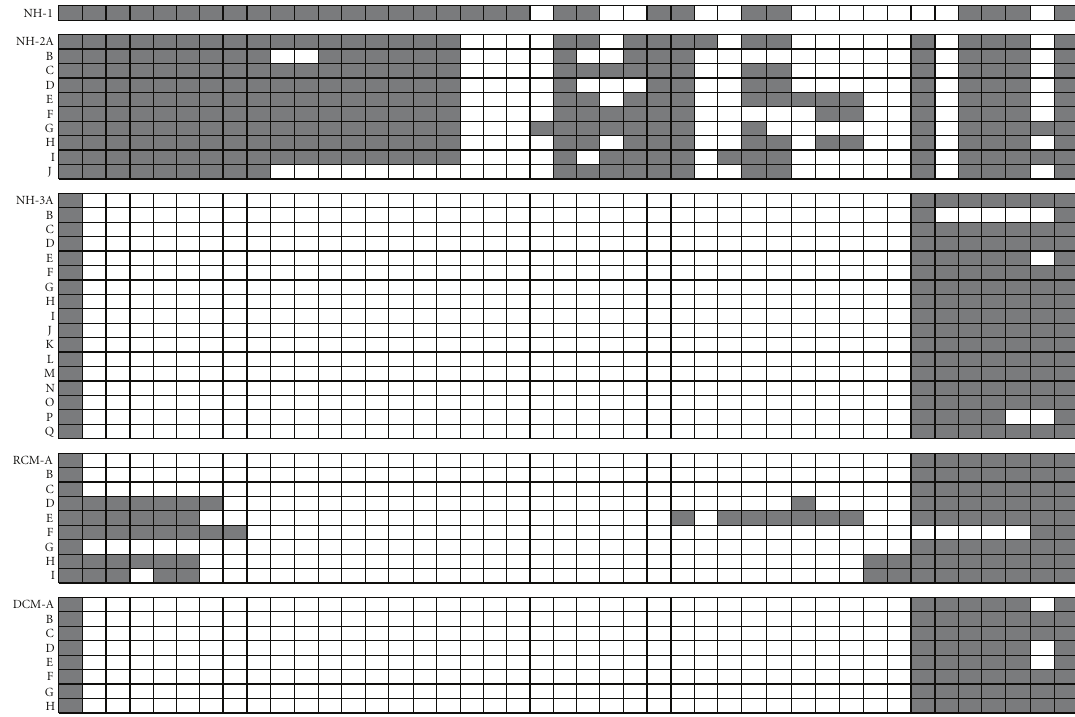
Figure 3: Exon inclusion in clones from the human titin PEVK region. Data from left ventricle samples of five di ff erent individuals—three normal (NH-1, NH-2, NH-3), one restrictive cardiomyopathy (RCM), and one dilated cardiomyopathy (DCM). Exon number is listed across the top. Filled boxes denote exon inclusion. Letter designations in each block refer to separate clones from each individual. Clones were obtained by PCR amplification after RT-PCR using primers from exons 108 and 225. Full details on the methods have been published [38]. Data from sample NH-1 is from [38] and for NH-2 clones from